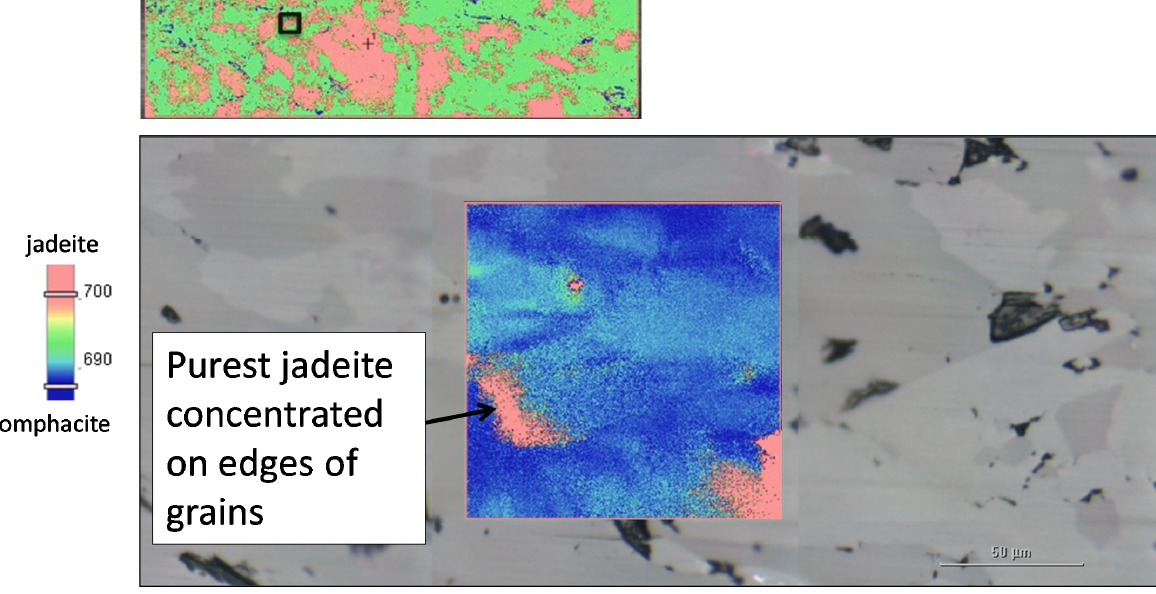
Figure 28. High-resolution Raman mapping of the Raman shift position (cm − 1 ) within a small area of the ring from Figure 27 shows jadeite concentrated at grain edges and a matrix of omphacite in between grains. The false color map ranges in color from jadeite (pink) to omphacite (blue) based on the position of the 678–700 cm − 1 primary Raman peak.